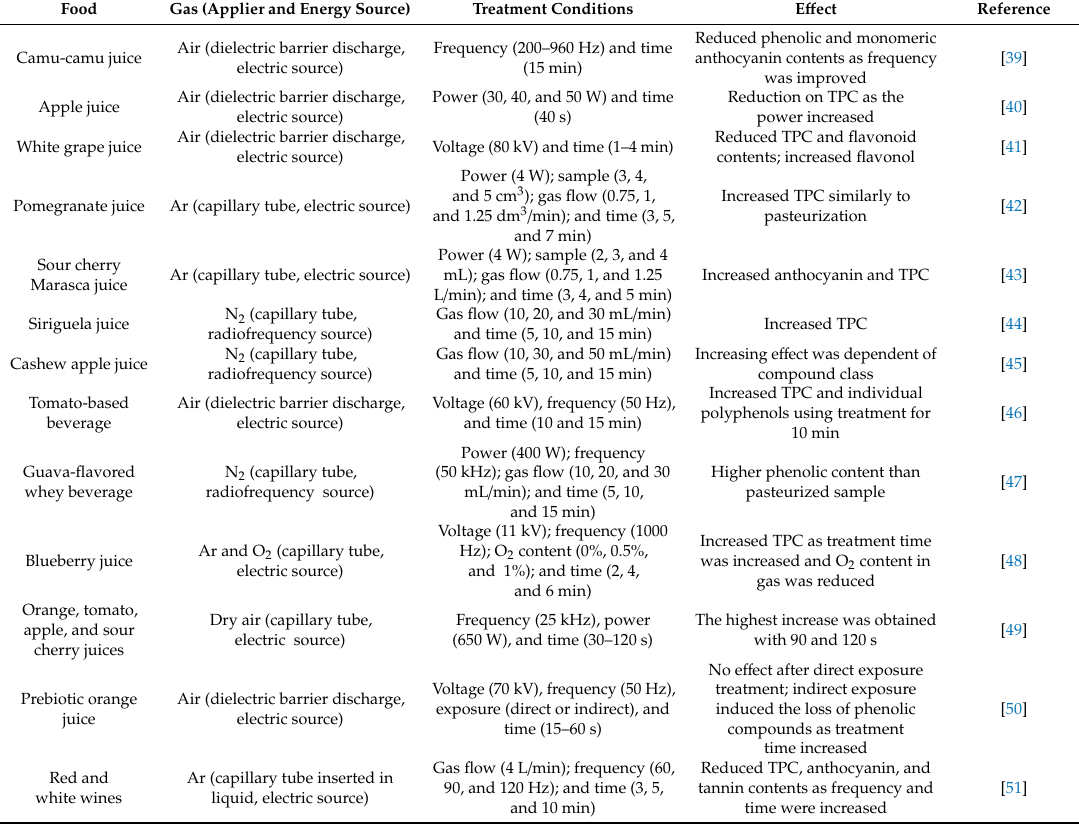
Table 2. Influences of plasma treatments on the polyphenols of beverages rich in phenolic compounds.